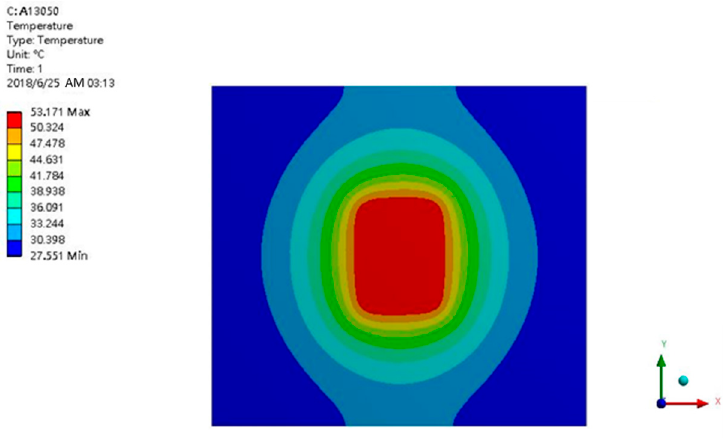
Figure 10. Temperature field distribution of thermal conductivity of 235.5 W / mK.